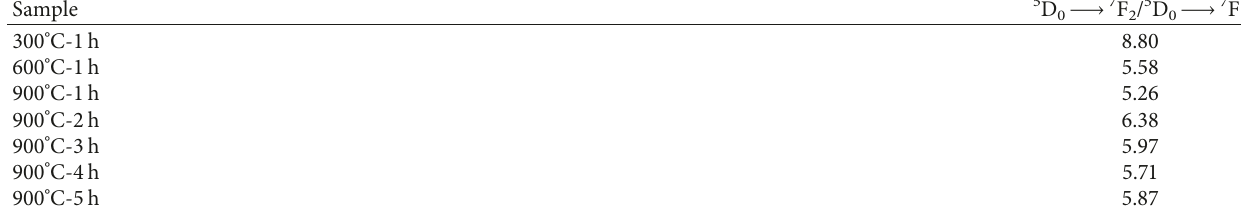
3+ samples synthesized 4 :Eu